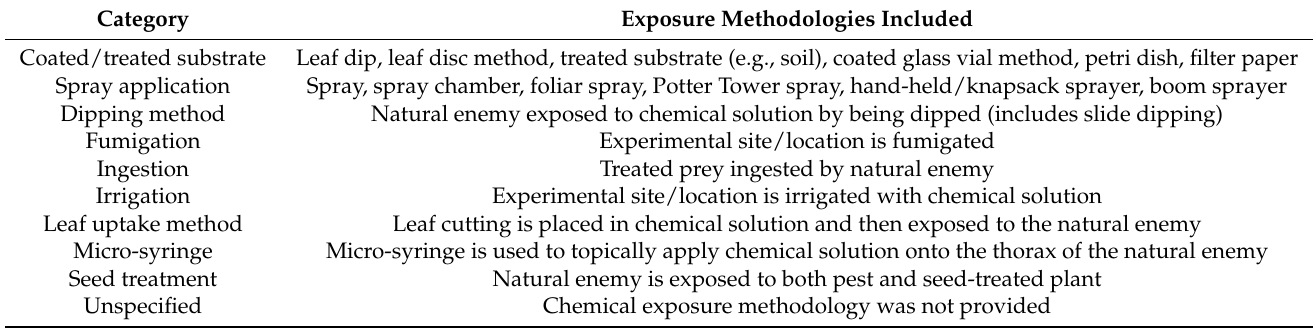
Table 3. Categories used to define the testing methodologies used to expose natural enemies to insecticides and miticides. Category Exposure Methodologies Included Coated/treated